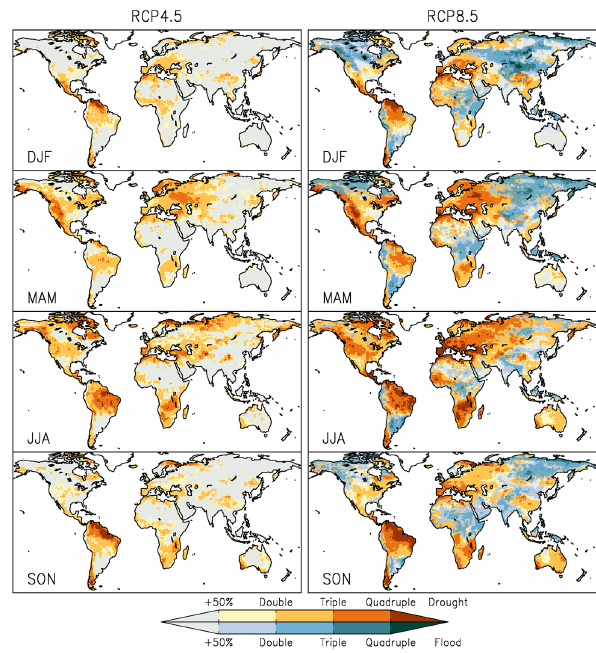
Figure 2. As in Fig. 1 for moisture in top 10cm of soil.